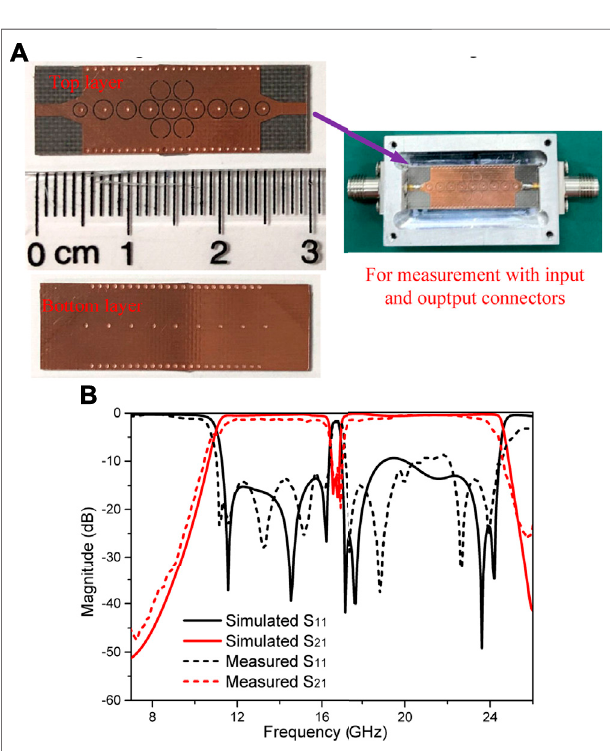
FIGURE3|(A) FabricatedphotographoftheBPFwithanotchbandand (B) the simulated and measured S -parameters of the